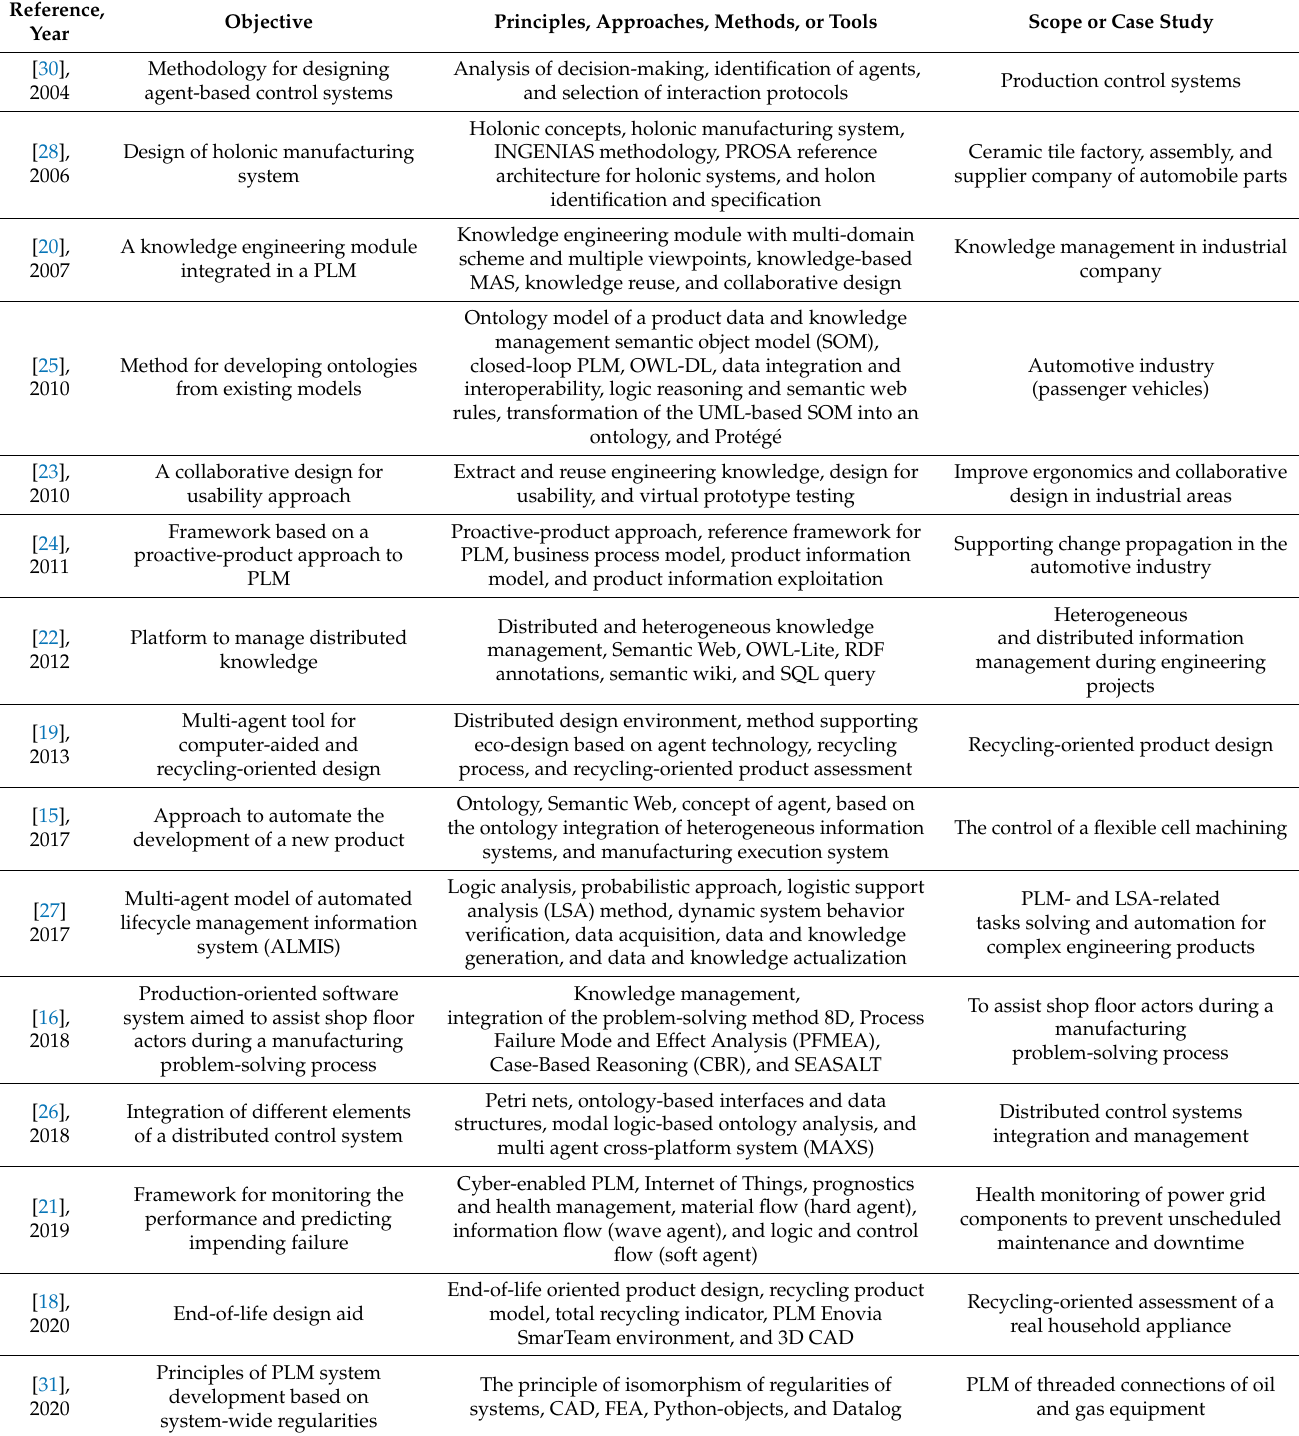
Table 1. Some research in PLM using multi-agent and ontological